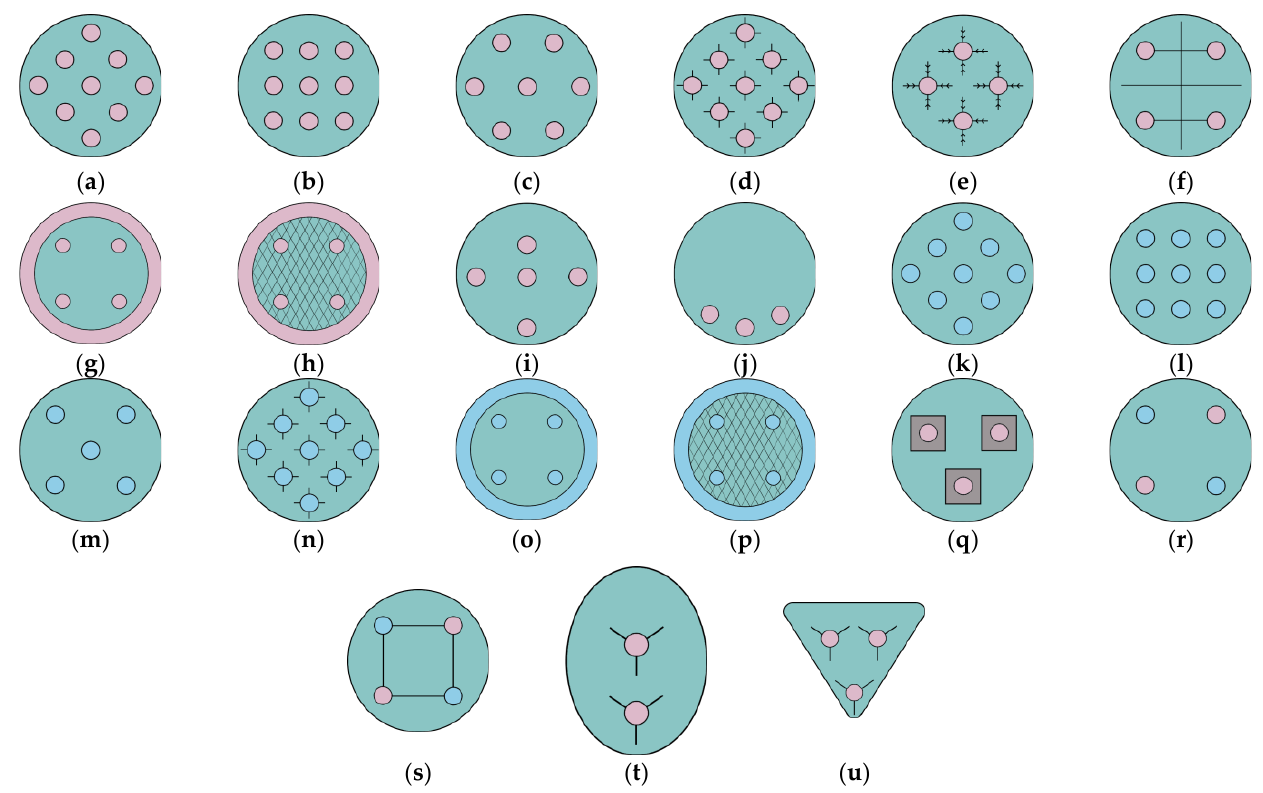
Figure 6. Horizontal multi-tube arrangements; ( a ) Case MTHC-M; ( b ) Case MTHL-M; ( c ) Case MTHS-